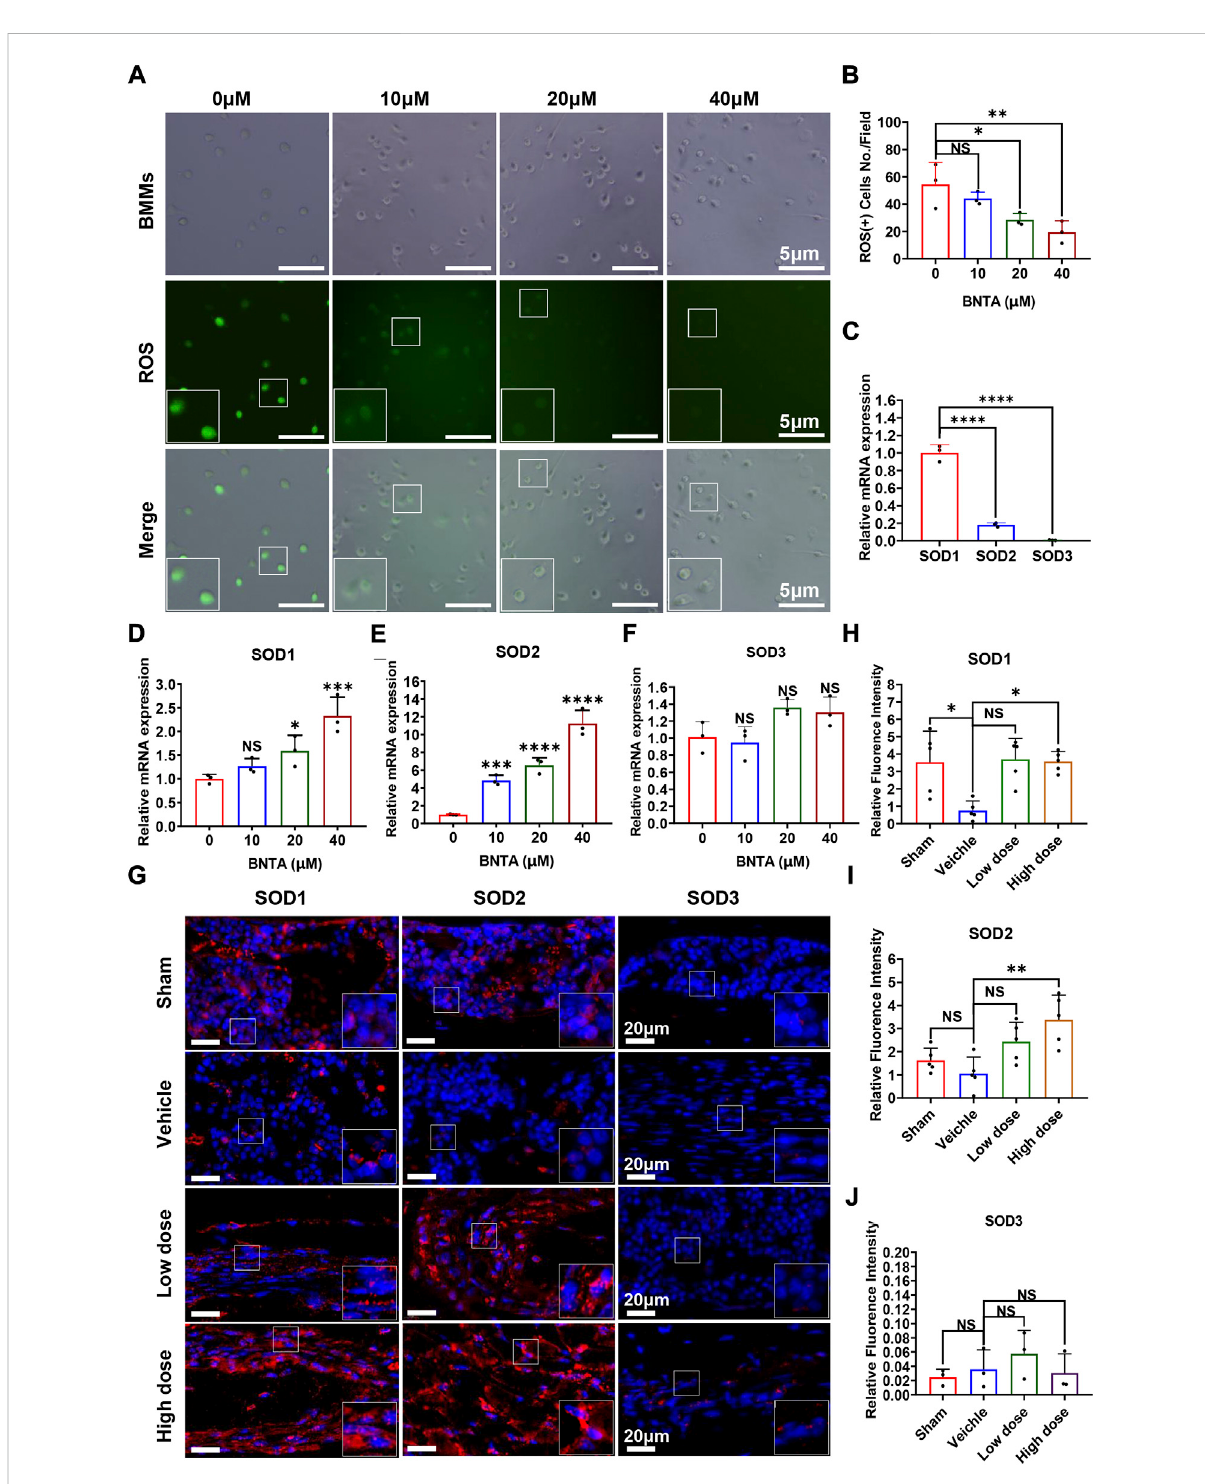
BNTA regulated Redox-related gene expression and inhibited intracellular ROS generation. (A) Representative fl uorescence images of RANKL- stimulatedROSproductioninBMMswithorwithoutpre-treatmentofindicateddoseofBNTA. (B) Quanti fi cationofthenumberofROSpositive cells per fi eld ( n = 3 per group). All data are presented as mean ± SD. * p < 0.05, ** p < 0.01. (C) qPCR analysis of mRNA expression of SOD1, SOD2, and SOD3 relative to GAPDH in BMMs stimulated by RANKL for 5 days without stimulation of BNTA ( n = 3 per group). All data are presented as mean±SD.**** p < 0.0001comparedwithcontrolgroup. (D – F) qPCRanalysisofredox-relatedgenesexpressionofSOD1,SOD2,andSOD3relative toGAPDHinBMMsstimulatedbyRANKLfor5 dayswithorwithoutanindicateddoseofBNTA( n =3pergroup).Alldataarepresentedasmean±SD. * p < 0.05, *** p < 0.001, **** p < 0.0001 compared with control group. (G) Representative immuno fl uorescence staining images of decalci fi ed bone sections for protein expression of SOD1, SOD2, and SOD3. (H – J) Quantitative analysis of protein expression of SOD1, SOD2, and SOD3 in vivo . * p < 0.05, ** p < 0.01 compared with control